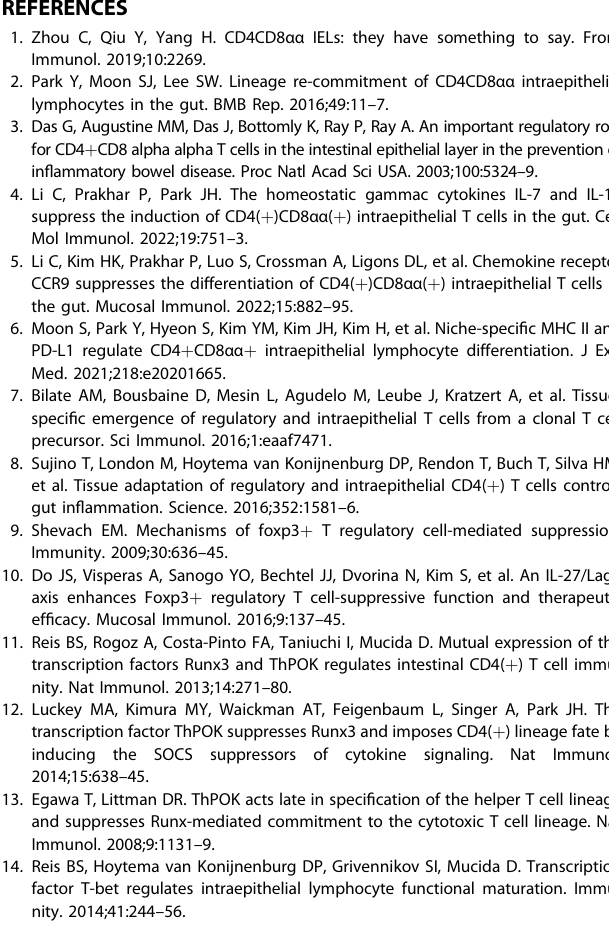
Fig. 1 Runx3d controls CD4 + CD8 αα + IELs in the SI epithelium. a CD4 versus CD8 pro fi les of αβ T cells in the SI epithelium and LN (top) and CD8 α versus CD8 β plot of CD4 + CD8 α + DP and CD4 – CD8 α + SI IEL T cells (bottom). The results are representative of 5 independent experiments. b GFP reporter expression after 4 h of PMA and ionomycin stimulation in freshly isolated and 3-day in vitro anti-CD3/CD28-activated CD4 + CD8 αα + SI IEL T cells from WT (black line) and Il10 -GFP reporter mice (red line). The results are representative of 3 independent experiments. c IL-10 expression after 4 h of PMA and ionomycin stimulation in freshly isolated CD4 + CD8 αα + and CD4 + Foxp3 + SI IELs. The results are representative of 3 independent experiments. d LAG-3 expression in the indicated αβ T-cell IEL populations of Foxp3 -GFP reporter mice. The data are shown as histograms (left), and bar graphs are a summary of 2 independent experiments (right). e Runx3d -YFP reporter expression in the indicated populations of SI IELs. The results are representative of 3 independent experiments. f LAG-3 expression on Runx3d – / – and littermate controls (LMC) DP IELs. The data are shown as histograms (left), and bar graphs are a summary of 3 independent experiments (right). g IL-27R α expression on Runx3d – / – and LMC DP IELs. Bar graphs are a summary of 2 independent experiments with a total of 3 Runx3d – / – and 3 LMC mice. h Intracellular staining for T-bet and ThPOK in CD4 + CD8 αα + IELs of Runx3d – / – and LMC mice. Histograms are representative of 3 independent experiments. i IL- 10 expression after PMA and ionomycin stimulation of 3-day anti-CD3/CD28-stimulated CD4 + CD8 αα + SI IELs from Runx3d – / – and LMC mice. The results are representative of 3 independent experiments. j CD4 versus CD8 α pro fi les of CD4 + CD8 β – SI IEL αβ T cells (top) and the frequency and number of CD4 + CD8 αα + IELs (bottom) in Runx3d – / – and LMC mice. The results show a summary of 7 independent experiments with a total of 8 Runx3d – / – and 8 LMC mice. k Intracellular Bcl-2 protein contents in CD4 + CD8 αα + IELs of Runx3d – / – and LMC mice. The data are shown as histograms, and the bar graph summarizes 3 independent experiments with a total of 5 Runx3d – / – and 6 LMC mice. l EdU incorporation was assessed in CD4 + CD8 αα + IELs 16 h after EdU i.p. injection in Runx3d – / – and LMC mice. The contour plot is representative of 4 independent experiments. m CD4 versus CD8 α pro fi les of CD4 + CD8 β – SI IEL αβ T cells (left) and the frequency and number of CD4 + CD8 αα + IELs (right) in Bcl-2 Tg and WT mice. The results show a summary of 3 independent experiments with a total of 5 Bcl-2 Tg and 5 WT